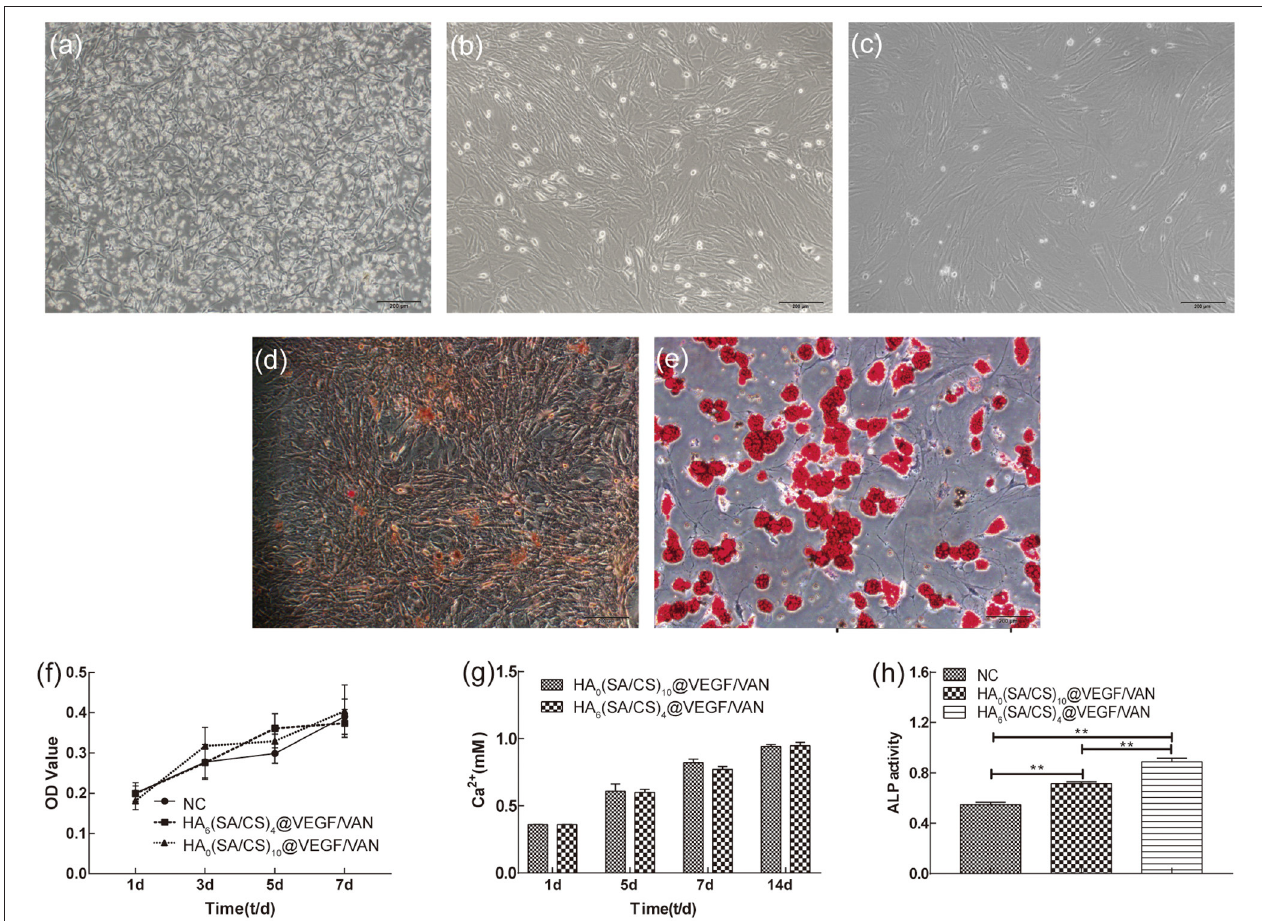
FIGURE 7 | (a) Morphology of primary BMSCs. (b) Morphology of first generation BMSCs. (c) Morphology of third generation BMSCs. (d) Alizarin red staining showed calcium nodules. (e) Oil red O staining showed lipid droplets. (f) Cytotoxicity test of blank group, HA 0 (SA/CS) 10 @VEGF/VAN scaffold and HA 6 (SA/CS) 4 @VEGF/VAN scaffold. (g) Ca 2 + released from the scaffolds. (h) Results of ALP activity measurement in each group. ** p <